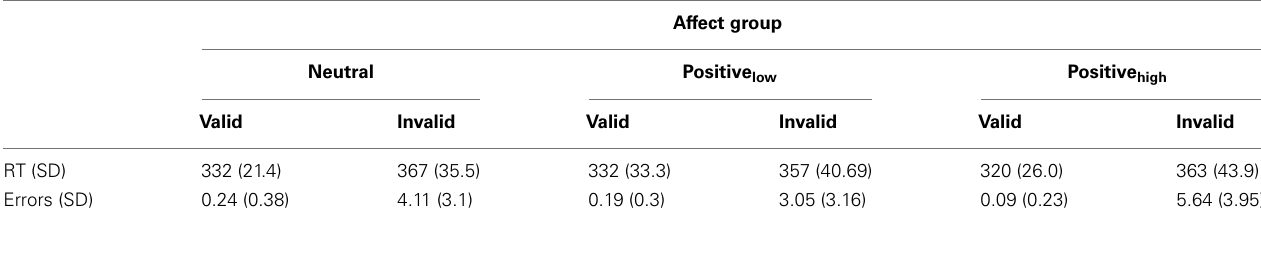
Table 1 | Mean RTs (in ms) and error rates (in %) in the spatial response cueing task of experiment 1 as a function ofAffect group and Cue